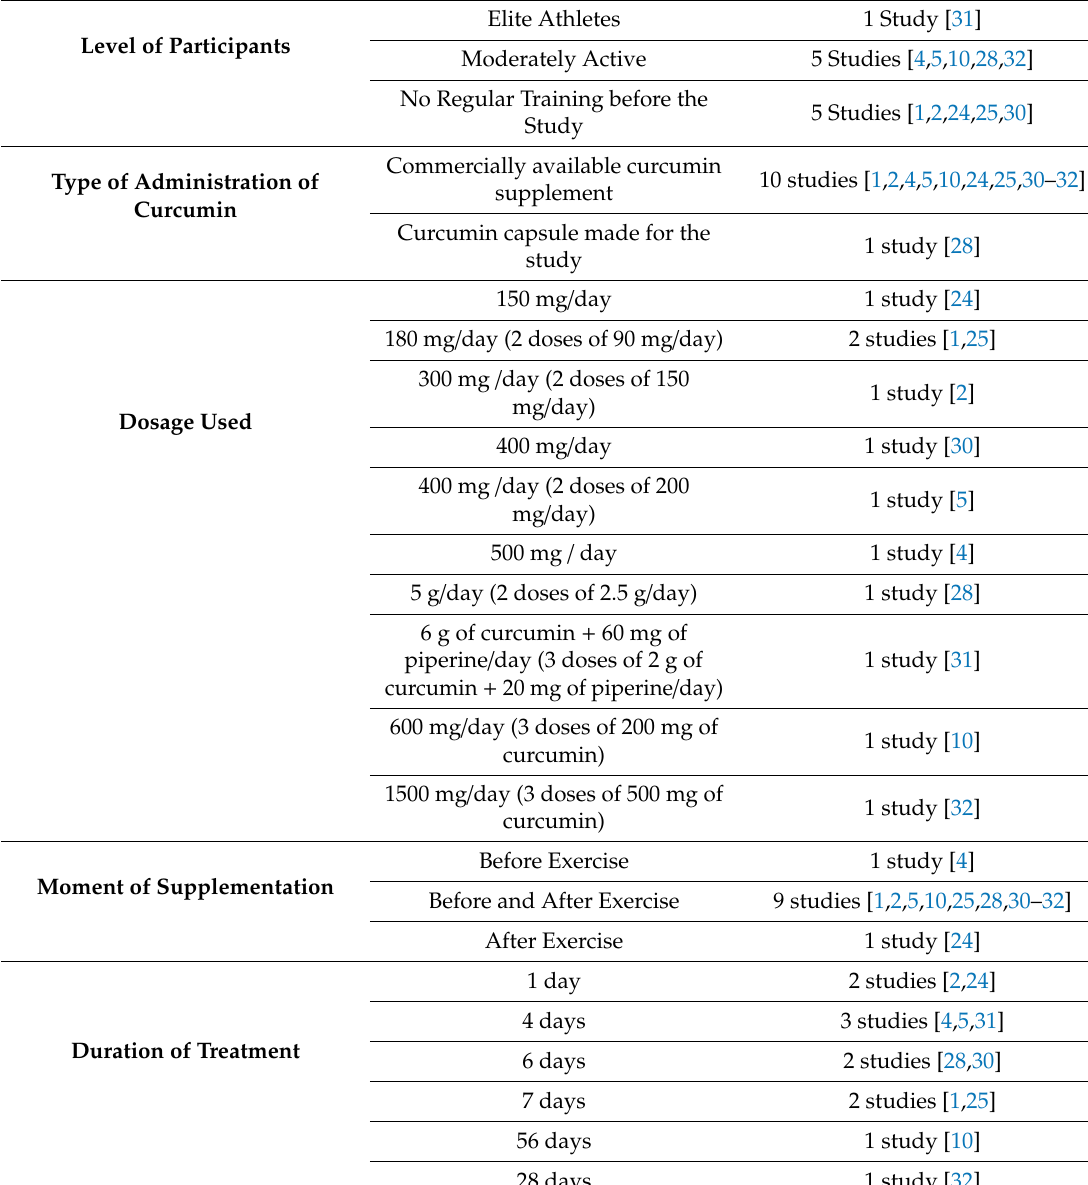
Table 2. Characteristics of participants and interventions in the studies included in the